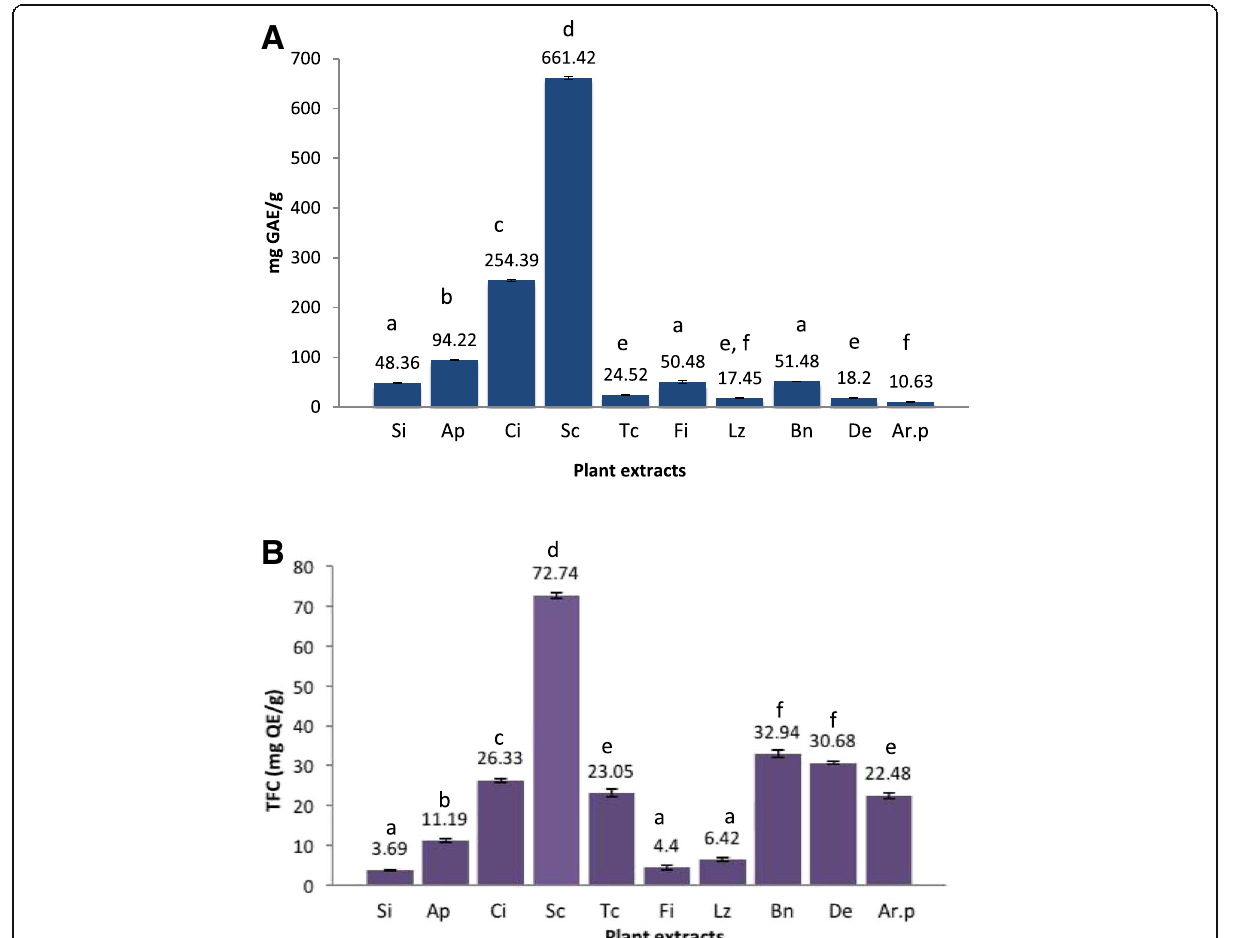
Fig. 4 Total polyphenolic contents ( a ) and total flavonoid Contents ( b ) of plant extracts. Results are presented as mean ± SE ( N = 3). Means followed by the same letter are not significantly different at p < 0.05. Si :Sphaeranthus indicus, Ap :Acronychia pedunculata, Ci : Calophyllum innophyllum, Sc : Symplocos cochinchinesis, Tc :Tinospora cordifolia, Fi : Flacourtia indica, Lz : Leucus zeylanica, Bn :Barathranthus nodiflorus, De : Diospyros ebenum, Ar.p: Argyria populiflia.